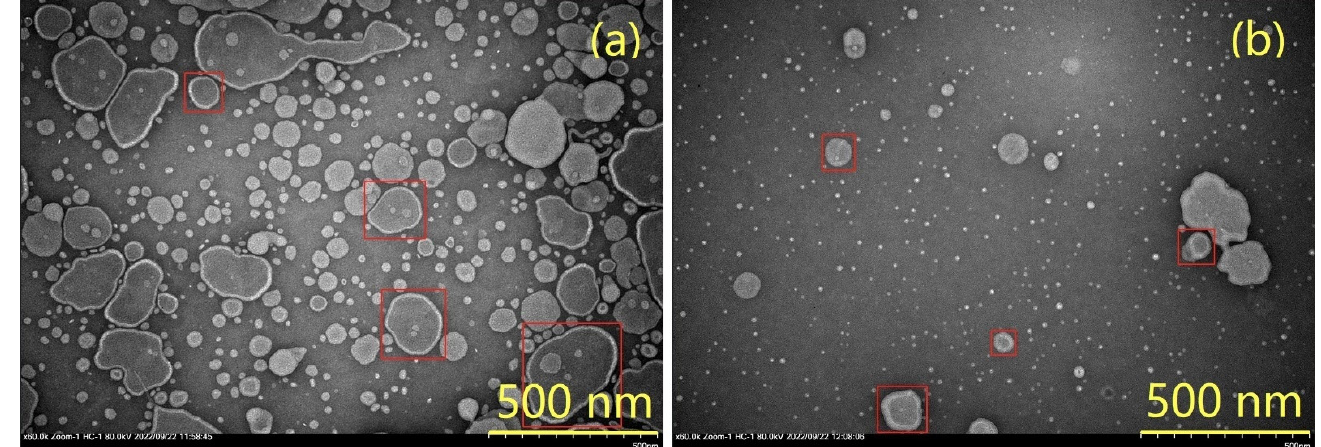
Figure 1. Transmission electron microscopy (TEM) images: ( a ) liposomal vitamin C with an average diameter near 200 nm; ( b ) liposomal vitamin D3 with an average diameter near 100 nm. Samples of bilayer (unilamellar) vesicles are indicated by a red square. The scale bars in panels ( a , b ) represent a 500 nm scale range (bottom right).